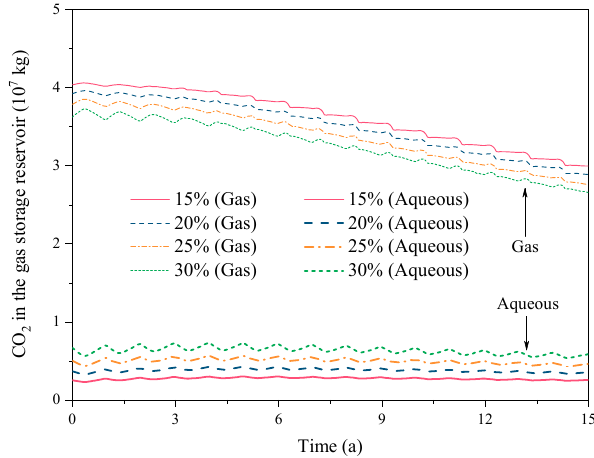
Figure 21. ( a ) Fluid flow in unsaturated porous rock and ( b ) fluid flow in water saturated porous rock [29].